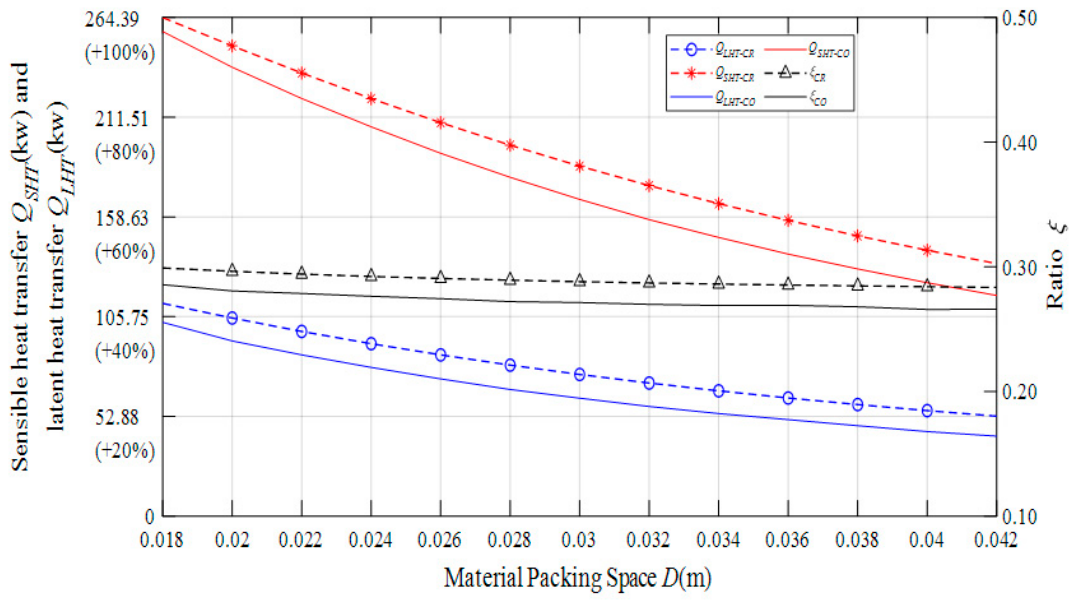
Figure 17. Influence of material packing space on energy transfer characteristics.